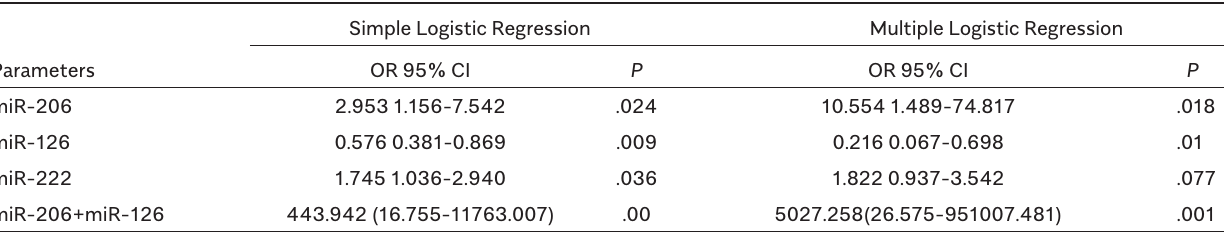
Table 3. Simple and Multivariate Logistic Regression Analysis to Identify Independent Risk Factors for the Development of HCC Simple Logistic Parameters